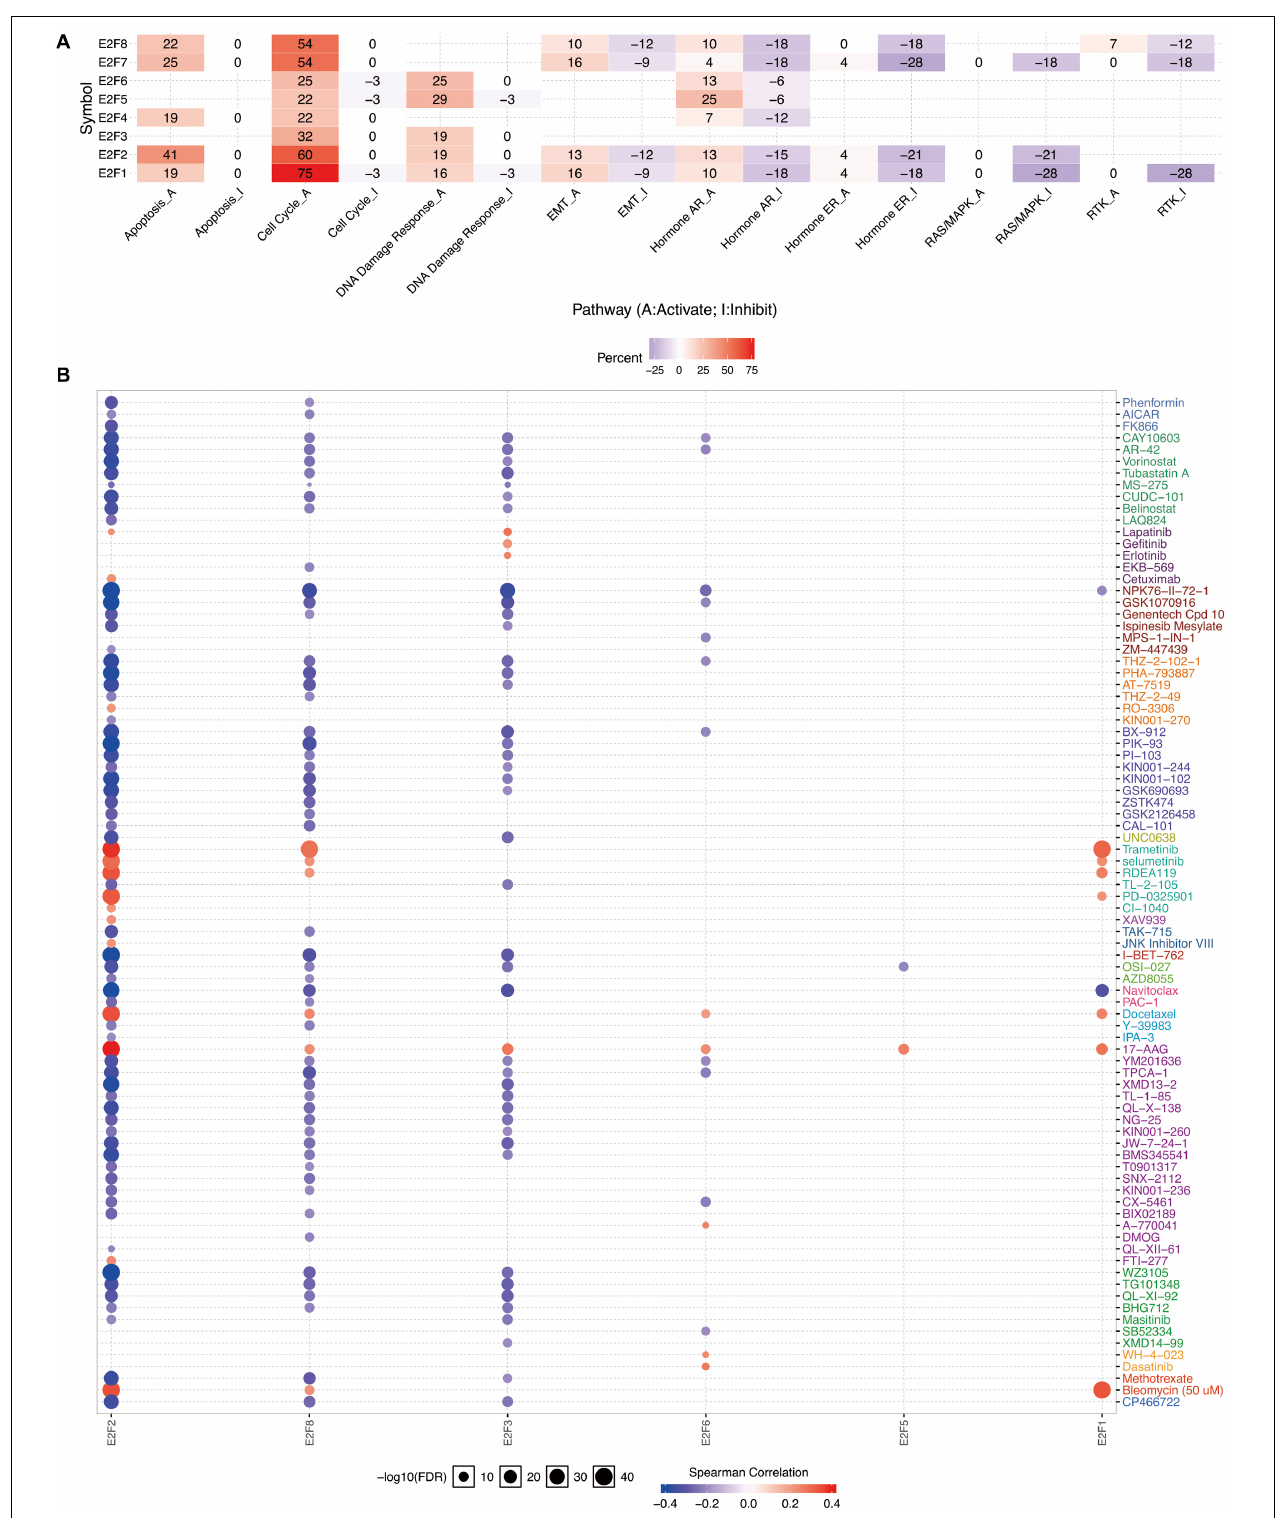
FIGURE 9 | The cancer related pathways and drug resistance analysis of E2Fs in UCEC. (A) The association between E2Fs and cancer-related activity. (B) The role of E2Fs in drug-sensitivity analysis.